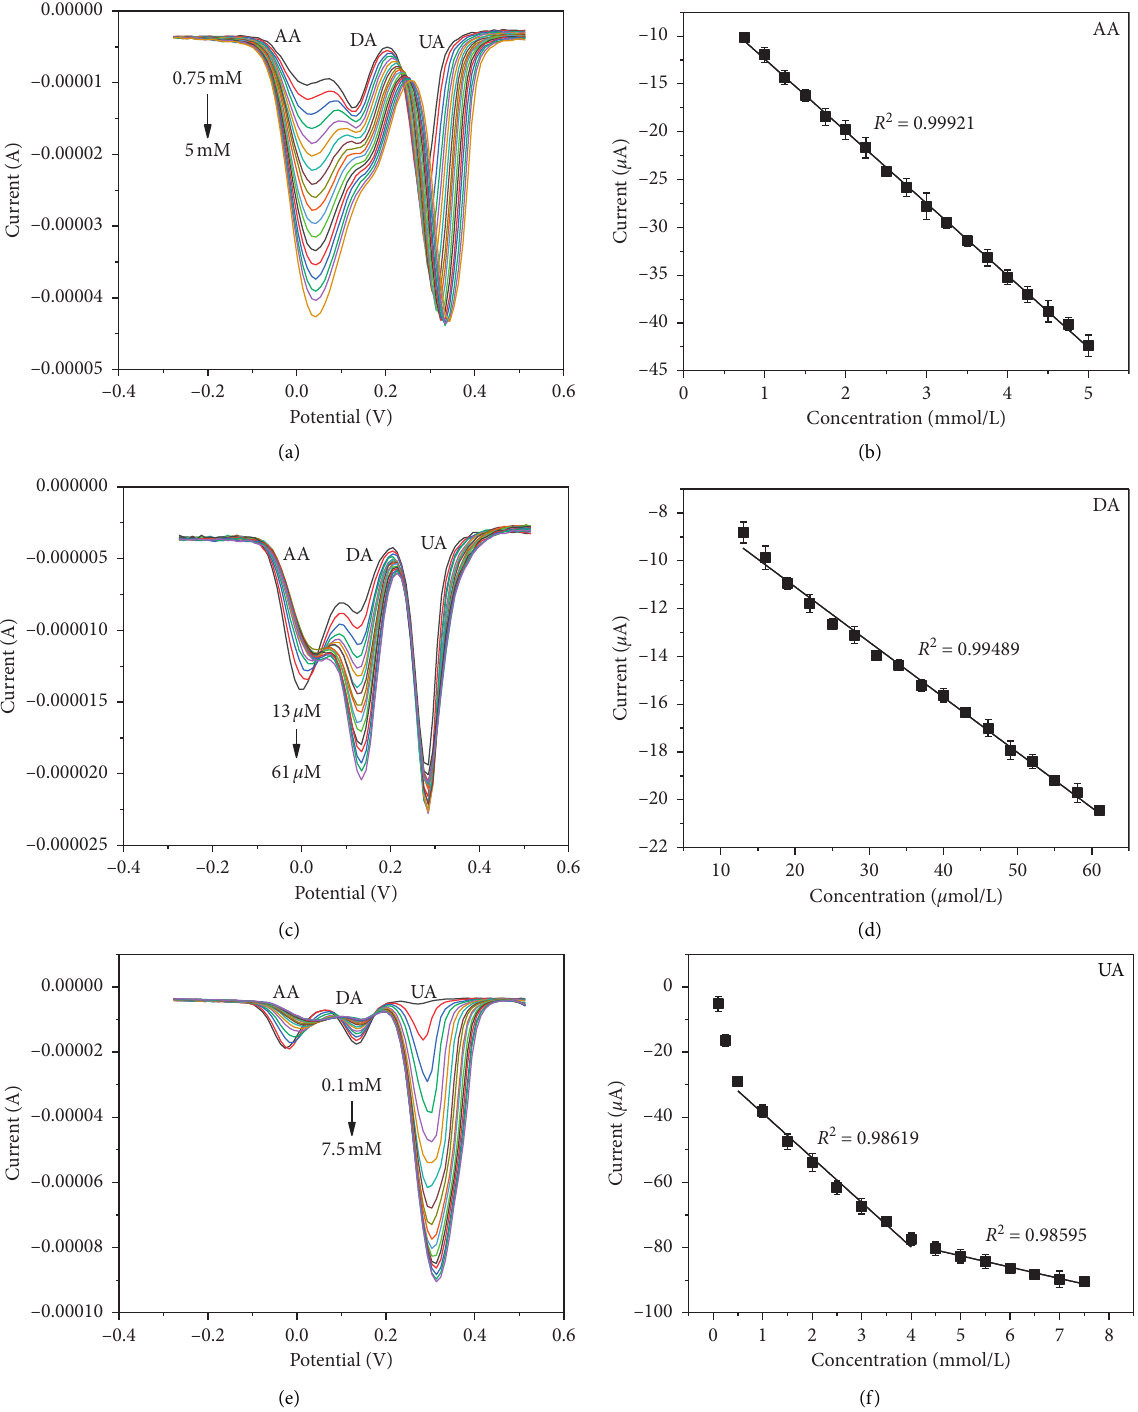
Figure 5: DPVs of different concentrations of (a) AA in the presence of 20 μ M DA and 0.5mM UA, (c) DA in the presence of 1.5mM AA and 0.5mM UA, and (e) UA in the presence of 0.75mM AA and 10 μ M DA. Calibration plots for (b) AA, (d) DA, and (f)